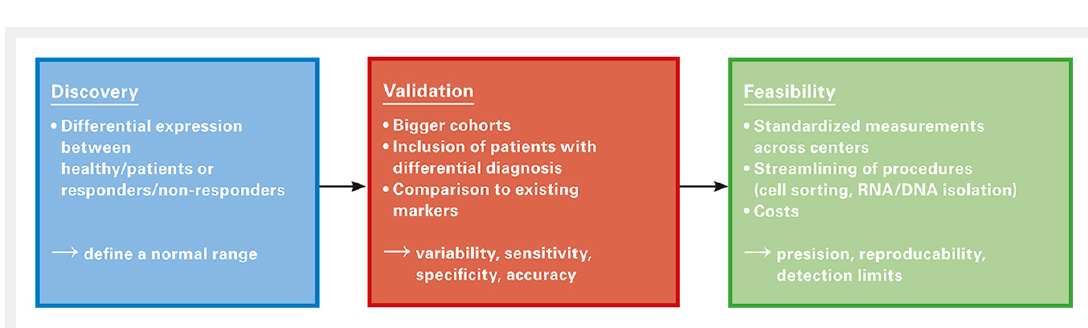
Acetyl (Ac), phospho (P) and methyl (Me) residues are placed on specific amino acids of the protruding histone tails by writer proteins. Histone acetyl transferases (HATs) and histone deacteylases (HDACs) are the readers and writers of acetylation, respectively. Bromodomains (BRDs) bind acetylated histone tails and promote the formation of multiprotein complexes. The methyltransferase EZH2 is bound to long non-coding RNA (lncRNA), which confers sequence specific location. On the DNA, ten-eleven translocation (TET) proteins convert methylated cytosines (mC) to carboxylcytosine (caC), formylcytosine (fC), and hydroxylmethylcytosine (hmC). Modified from [48] Kyburz D, et al. Epigenetic changes: the missing link. Best Pract Res Clin. 2014;28(4):577–87, with permission from Elsevier.